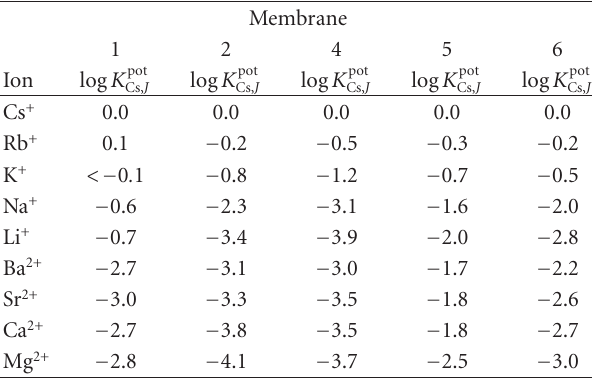
Table 3: Unbiased potentiometric selectivity coe ffi cients, log K pot of the Cs + -selective membranes evaluated in this